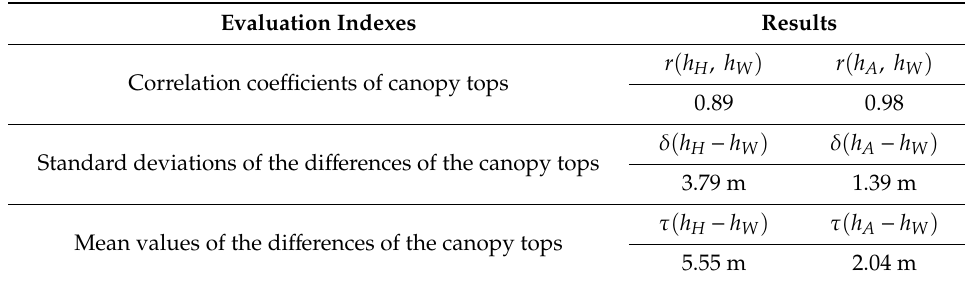
Table 2. The correlation coefficients of the canopy tops, and the standard deviations and the mean values of the differences of canopy tops derived from Tomoradar waveforms and coincident lidar data within Tomoradar HPBW and AEBW, respectively.